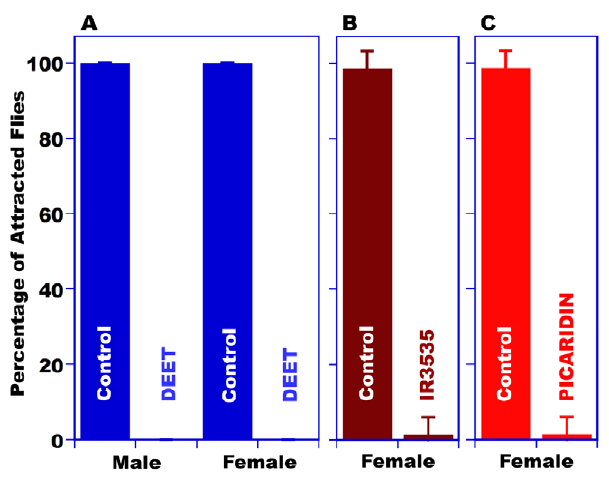
Figure 1. Repellency assay indicating avoidance of D.melano- gaster to three insect repellents: DEET, IR3535, and picaridin. ( A ) Male and female flies responded equally to DEET ( N =180 flies tested). Female flies avoid entering the food chambers treated with (B) IR3535 ( N =90 flies tested) and (C) picaridin ( N =90 flies tested). Data are from 9 independent trials for each test, with ten flies used in each trial.